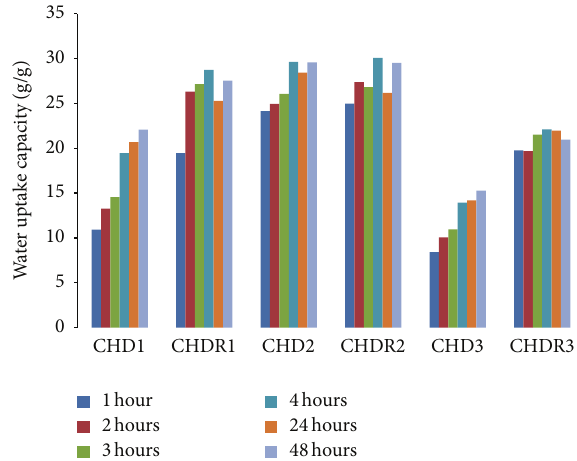
Figure 2: The water uptake for